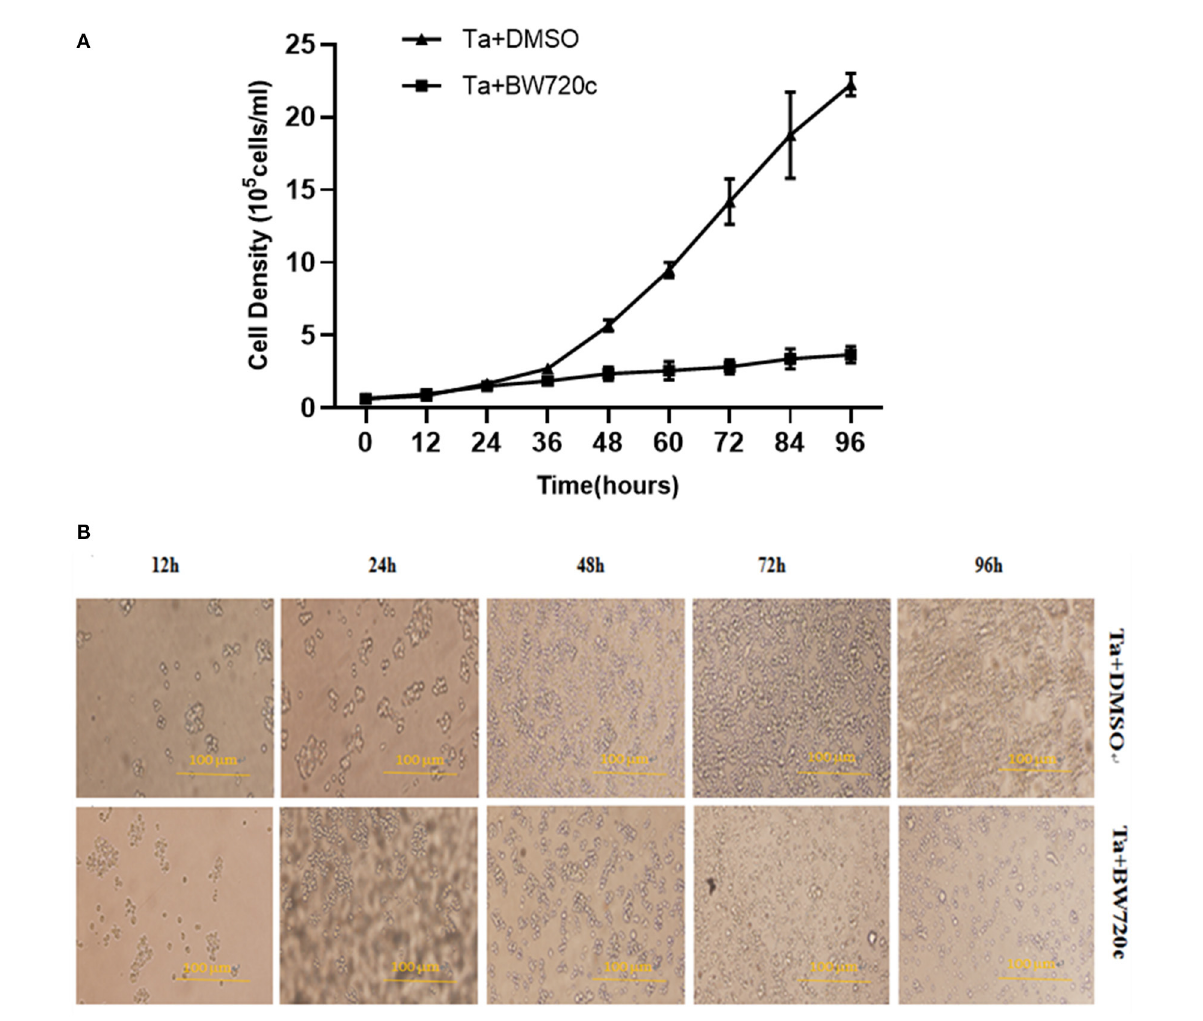
FIGURE4 Effect of DMSO and BW720c on the growth state of T. annulata transformed cells. (A) Growth curve of T. annulata transformed cells treated by DMSO and BW720c. (B) Affects of DMSO and BW720c for proliferation of the T. annulata transformed